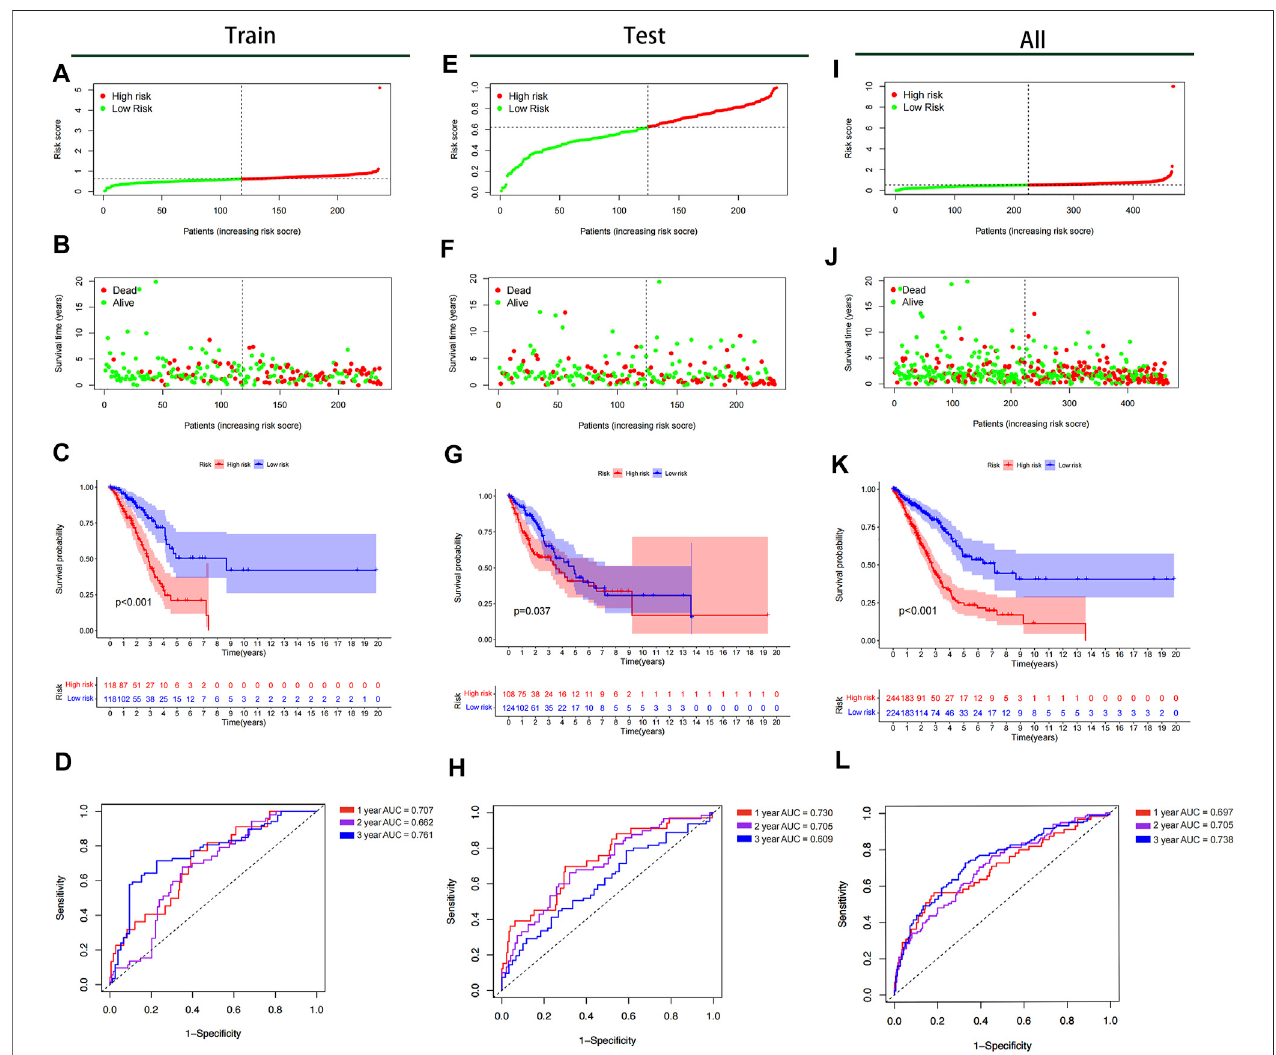
FIGURE 6 | Kaplan – Meier survival analysis, risk score analysis, heatmap, and time – ROC curve analysis. (A,B) Risk score, (C) Kaplan – Meier curve, (D) time – ROC curve of prognostic m6A-related lncRNA signature in the training cohort. (E,F) Risk score, (G) Kaplan – Meier curve, (H) time – ROC curve of prognostic m6A-related lncRNA signature in the test cohort. (I,J) Risk score, (K) Kaplan – Meier curve, (L) time – ROC curve of prognostic m6A-related lncRNA signature in the all cohort.